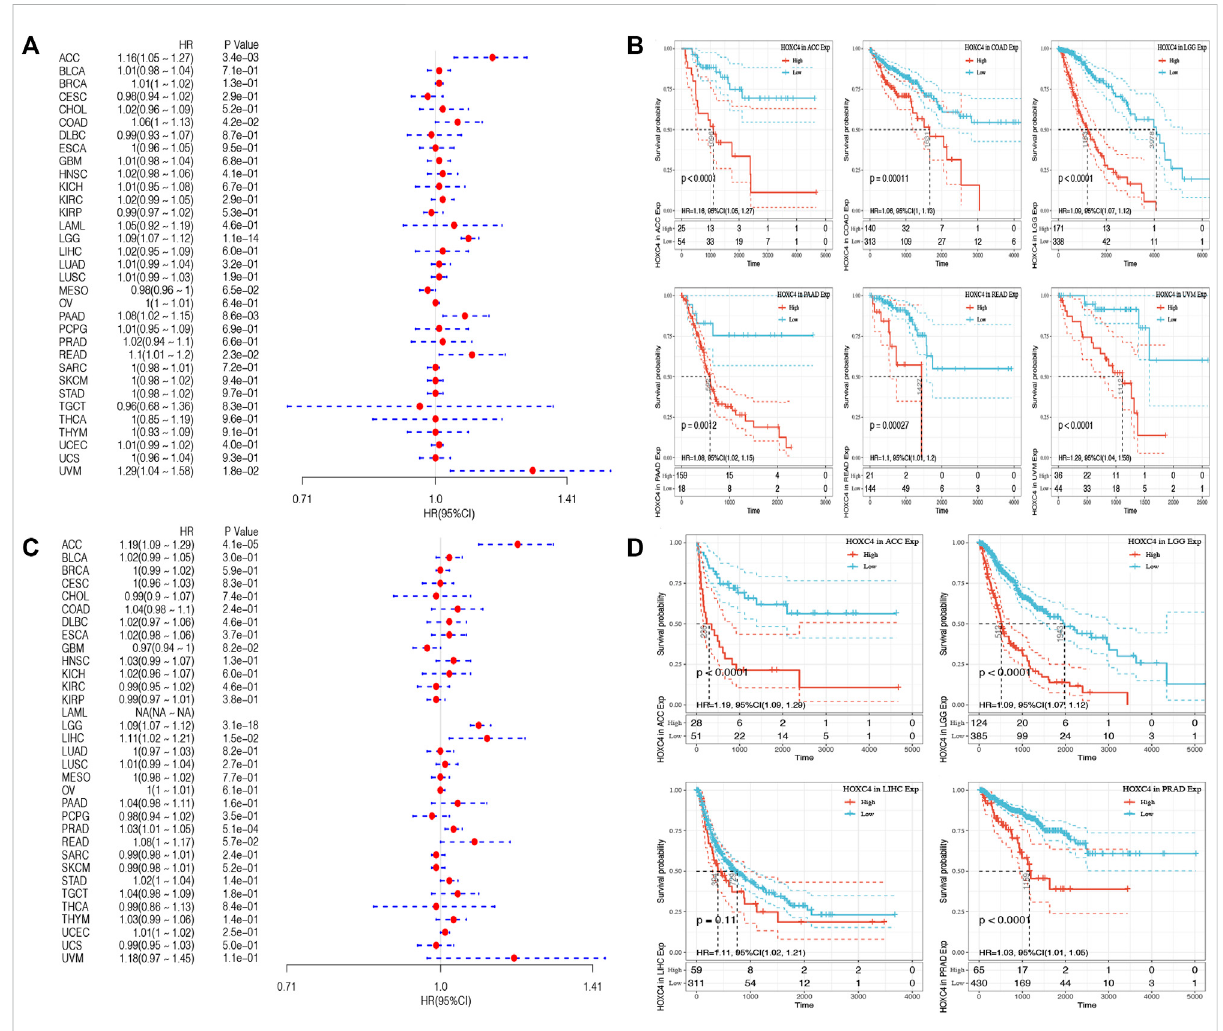
FIGURE 3 Forest plot and Kaplan-Meier curves of the relationship between HOXC4 expression and OS and PFI in 33 types of tumors (A,B) HOXC4expressionisassociatedwithDFIanalysisinACC,COAD,LGG,PAAD,READandUVM; (C,D) HOXC4expressionisassociatedwithPFIanalysis in ACC, LGG, LIHC and